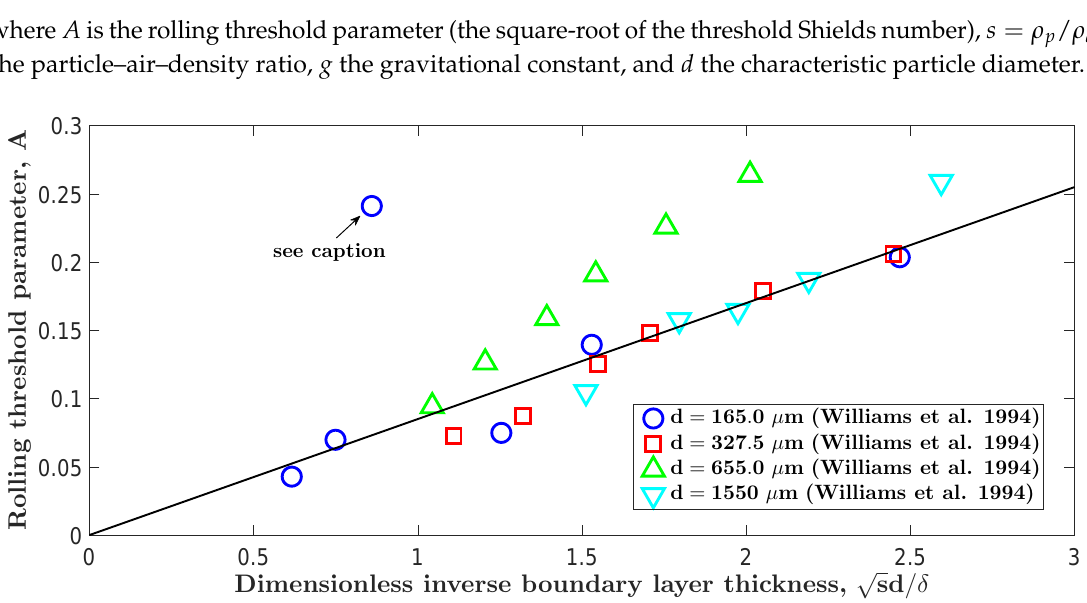
(cid:112) ( s − 1 ) gd versus dimensionless inverse boundary Figure 1. Rolling threshold parameter A = u ∗ t / √ sd / δ . Symbols correspond to the experimental data by Williams et al. [11], who set up layer thickness their wind tunnel in a manner that produces a developing turbulent boundary layer, for four different sediments consisting of nearly uniform, cohesionless particles. The line corresponds to the scaling Equation (1). We suspect that the one extreme outlier for d = 165 µ m may either have been a faulty measurement or be associated with the observation that the boundary layer for this particular sand sample was not always fully turbulent